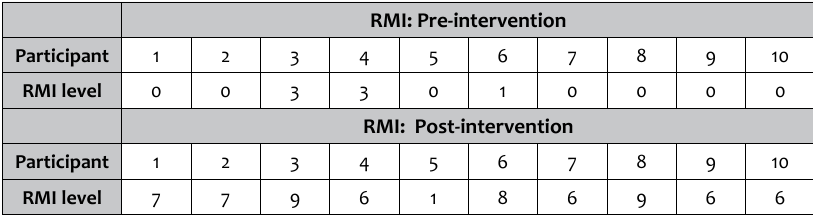
Table 6: Observations: Output phase